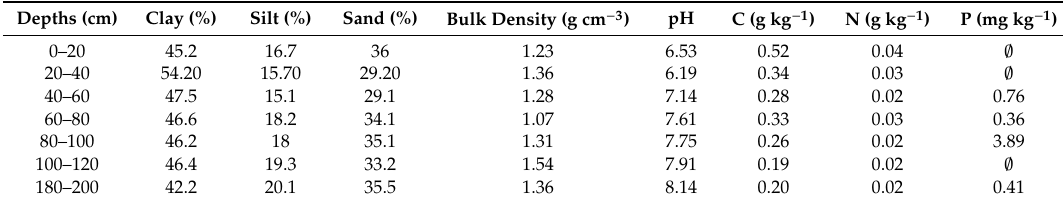
Table 1. Textural and chemical soil properties (Calciferric Vertisol) at N’Gakoro (13 ◦ 20’35.9” N 5 ◦ 51’24.8” W). Analyzed with auto capture pH-meter, CN-Analyzer, Optical Plate reader for P and Photometer for K (all K values were too low for measurements). ∅ = too low for measurement. pH measured in H 2 O solution, C and N analyzed by Hecker-standard, P and K